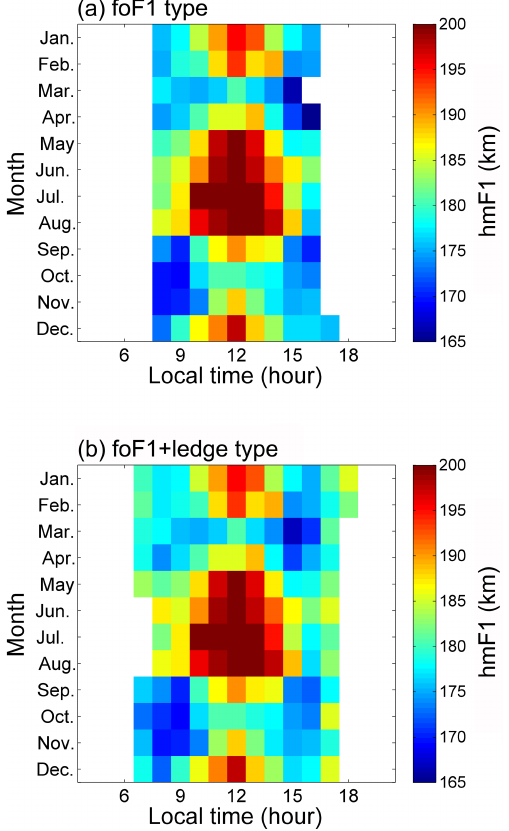
Figure 3. The monthly median hm F1 values for the (a) fo F1 and (b) fo F1 + ledge types of the Jicamarca digisonde during January– December